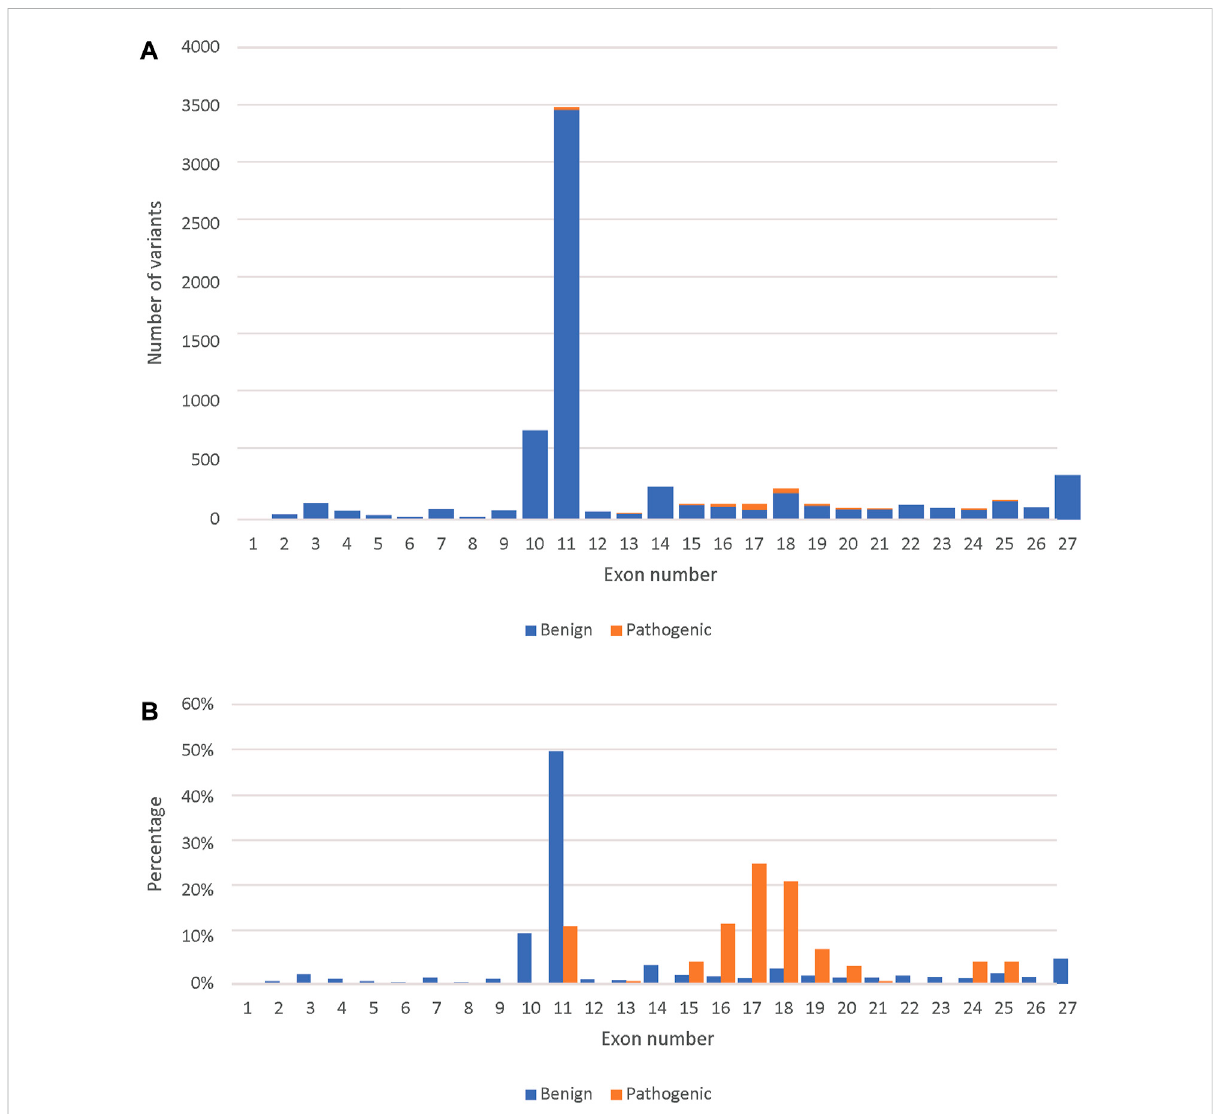
FIGURE 3 Comparison between the predicted pathogenic and benign variants across the BRCA2 exons. (A) The number of predicted pathogenic and benign missense variants (7,131) per BRCA2 exons. (B) Percent distribution of predicted pathogenic and benign missense variants across the BRCA2